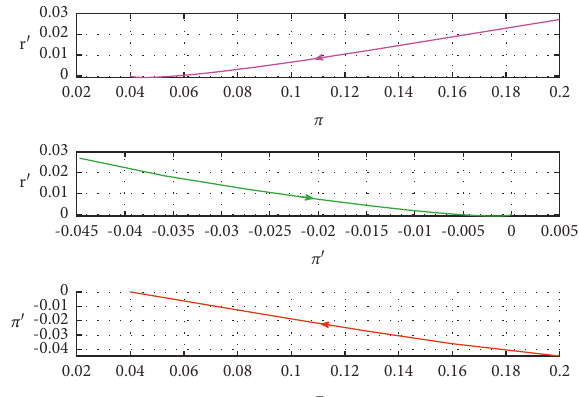
Figure 7: Three-dimensional phase portrait.